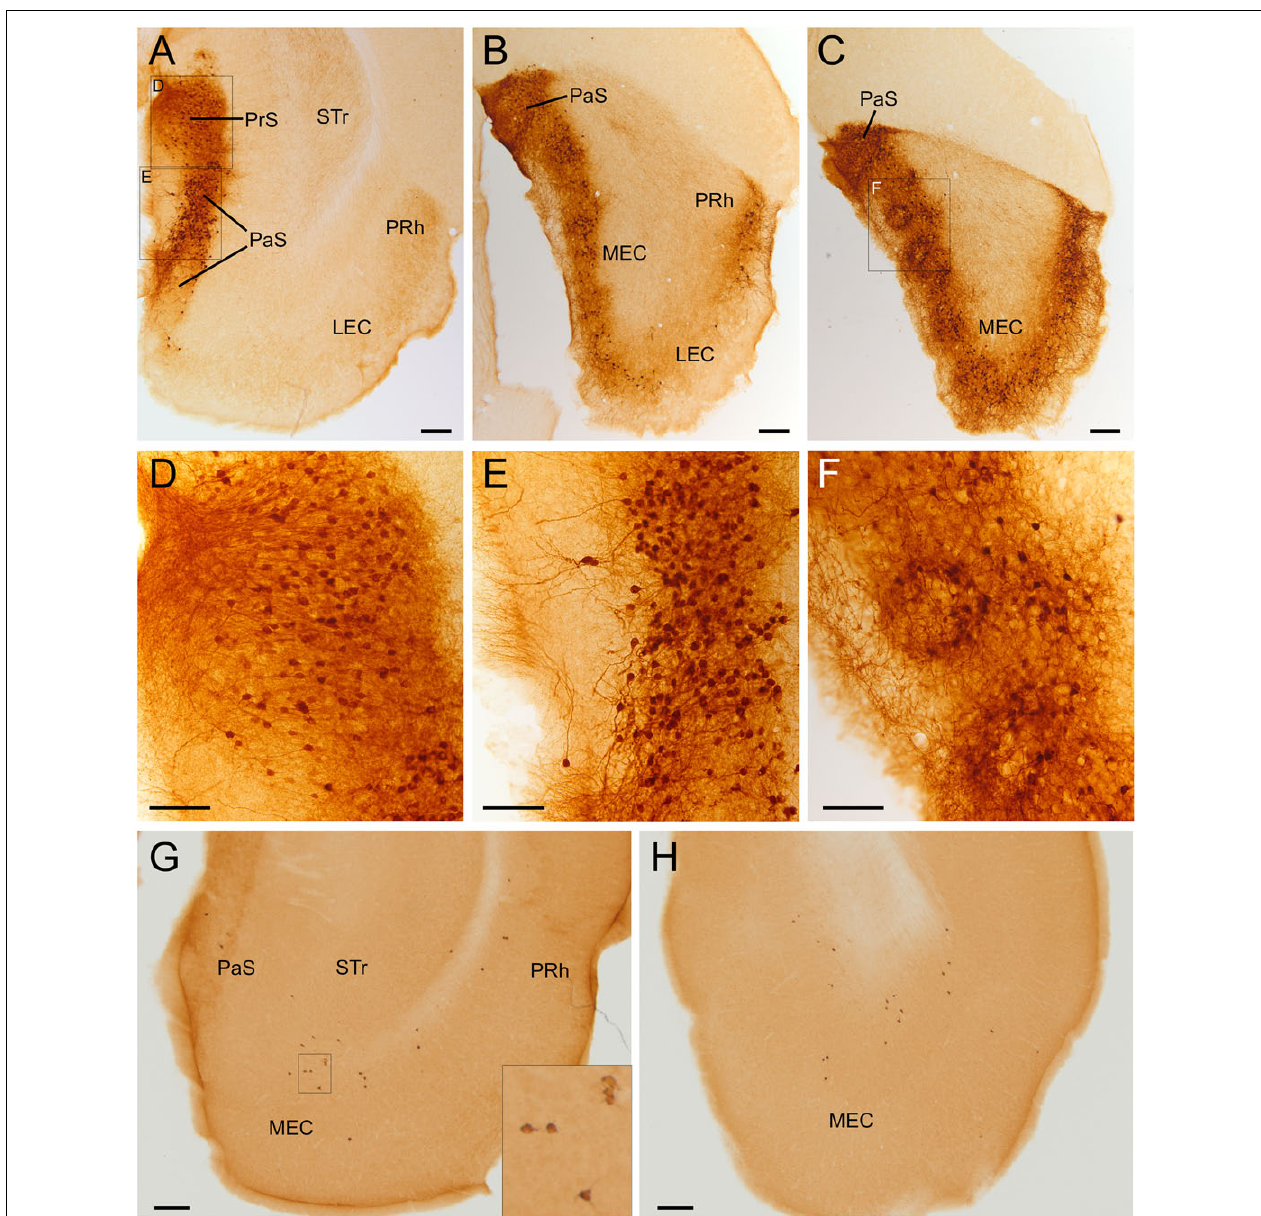
FIGURE 10 | GFP and HA immunoreactivity in the adult parahippocampal lobe. Images of frontal brain sections of adult Otp-eGFP mice (A–F) and adult Otp-Cre; Rpl22-HA mice (G,H) , showing GFP immunoreactive cells and neuropil (neuropil only seen in the Otp-eGFP) in several areas of the parahippocampal formation, including the presubiculum [ (A) , detail in panel (D) ], the parasubiculum [ (A–C) , detail from area squared in panel (A) in panel (E) ] and the caudomedial entorhinal cortex [ (B,C) , detail from area squared in panel (C) in panel (F) ]. Note the location of the labeled cells around the patches or islands of the medial entorhinal cortex. In the Otp-Cre; Rpl22-HA, labeled cells are observed in similar positions of the parahippocampal lobe to those in the Otp-eGFP, but in the first mouse line most cells occupy a deeper stratum (G,H) . See text and abbreviation list for more details. Scale bar: panels (A–C,G,H) = 200 µ m. Panels (D–F) = 100 µ